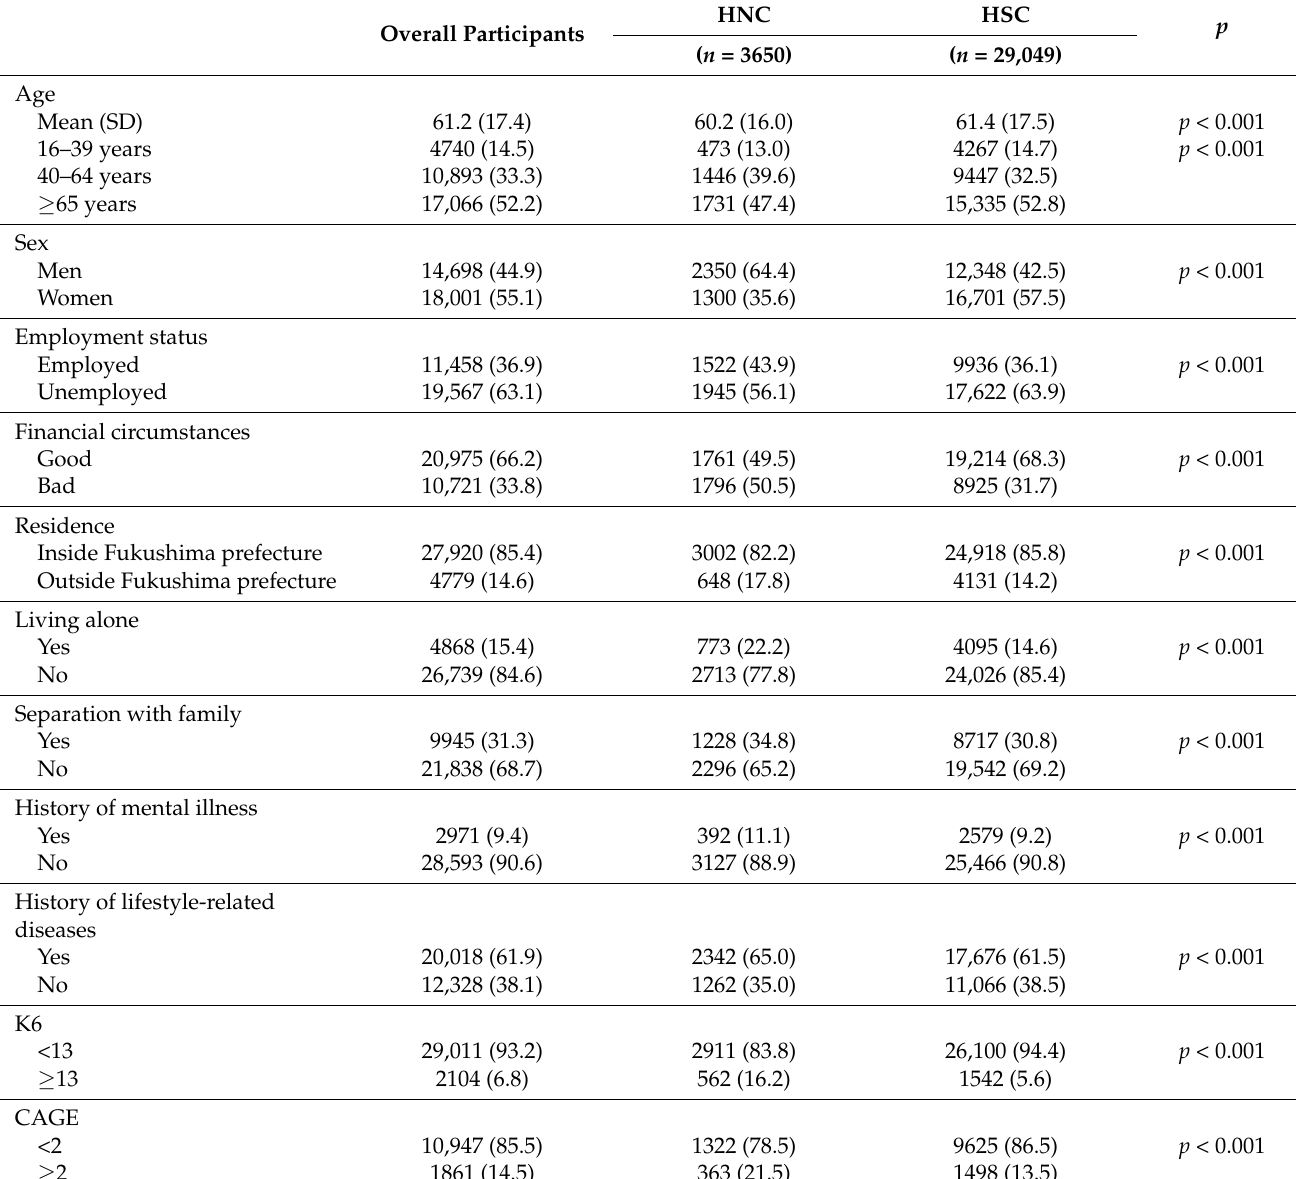
Table 1. Characteristics of